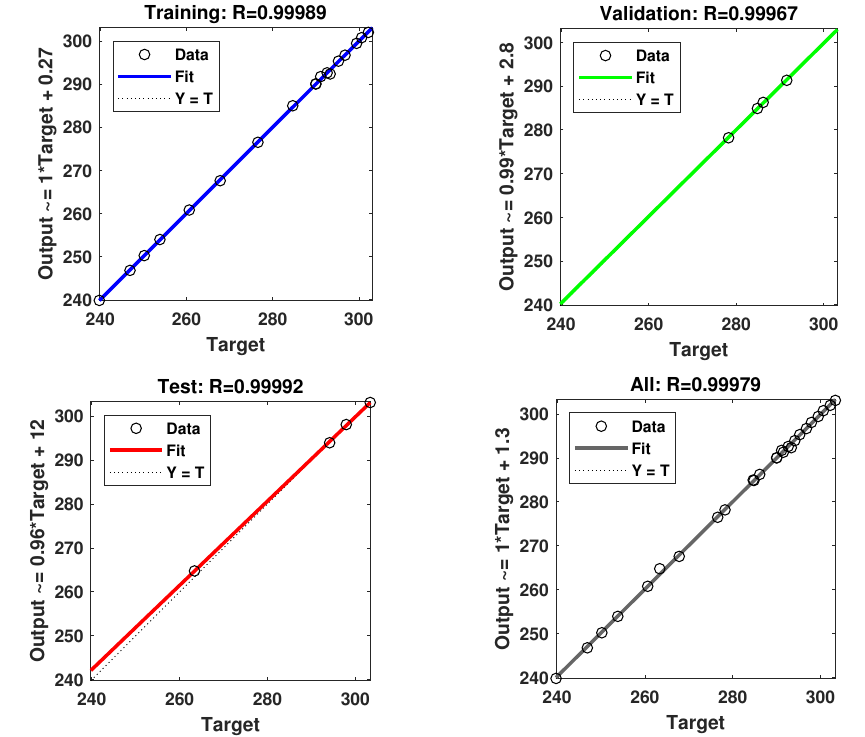
Figure 8. Training, validation and test results for regression of the ANN model.